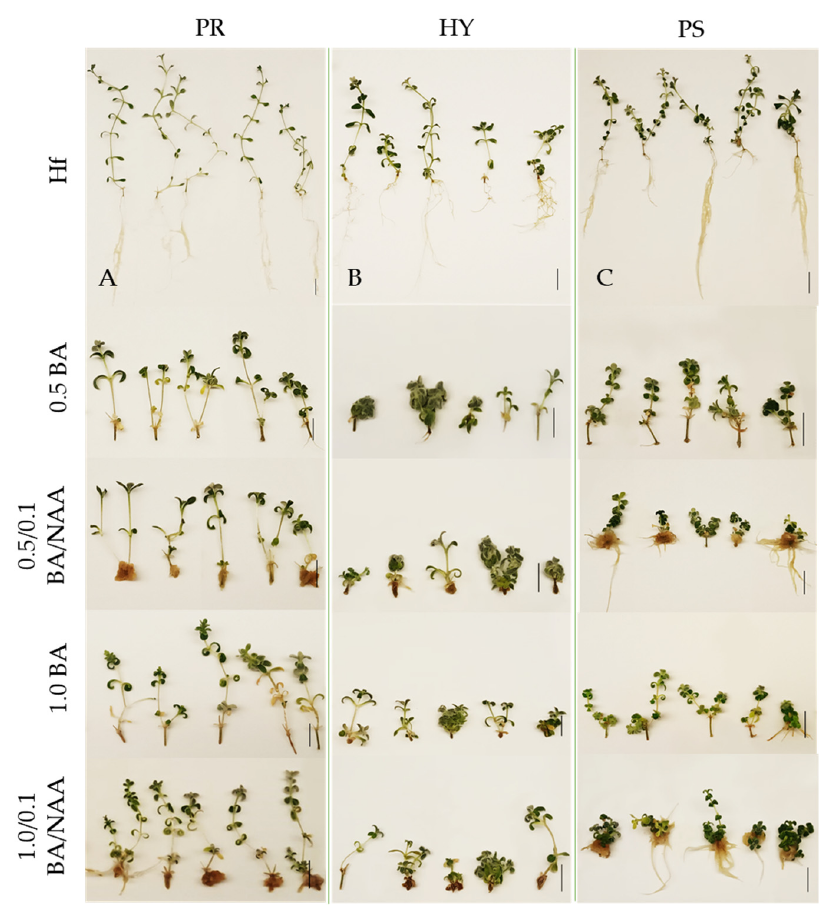
Figure 3. In vitro regeneration of three C. candidissimum populations after 50 days on different Mu- rashige and Skoog (MS) media, during the multiplication phase: ( A ) Parnitha population (PR); ( B ) Hymettus population (HY); ( C ) Parnassos population (PS). MS media either were hormone-free (Hf) or contained 6-benzyladenine (BA) at 0.5 or 1.0 mg L − 1 , without or with 1-naphthaleneacetic acid (NAA) at 0.1 mg L − 1 . Bars represent a length of 1.0 cm.